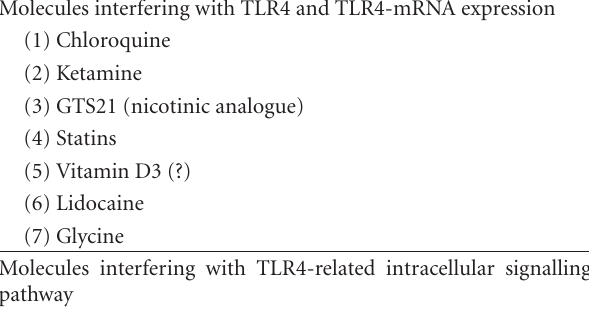
Table 1: Some of the natural inhibitors of TLR4 signalling. Level of action